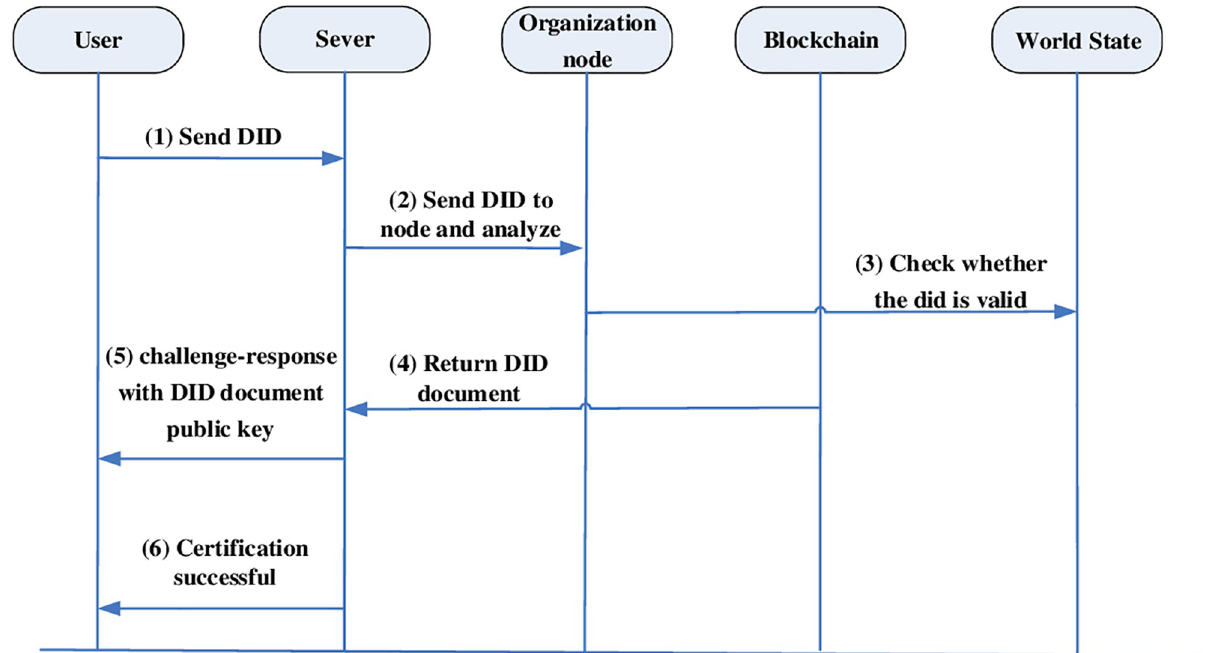
Fig 8. Distributed domain authentication